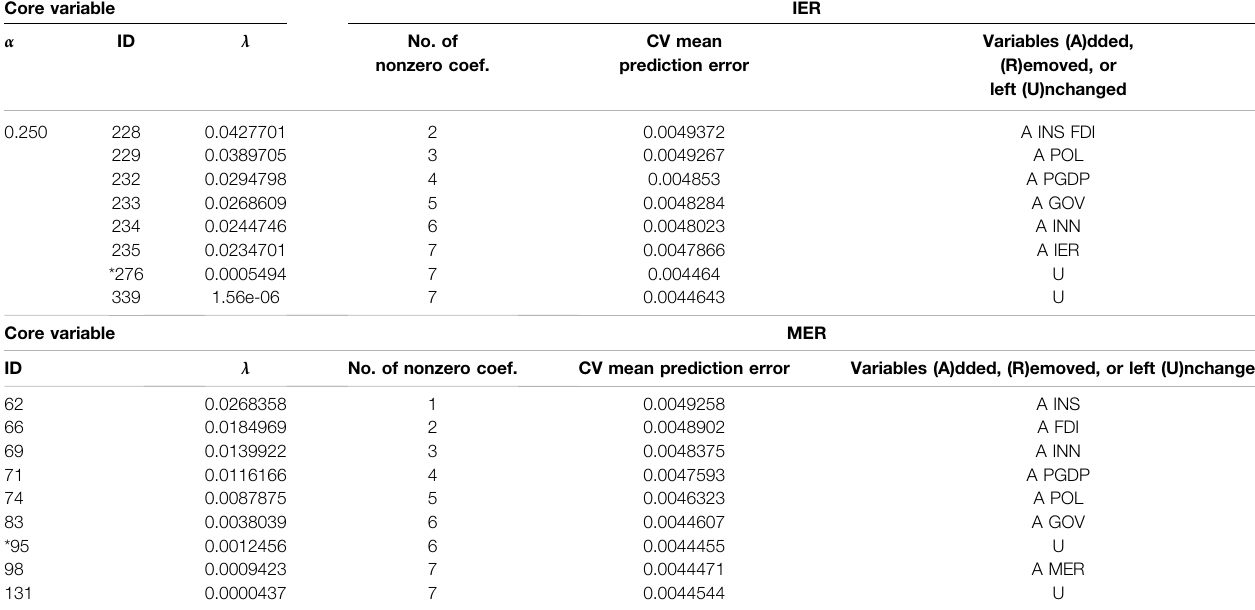
TABLE 5 | Process of λ value selection.